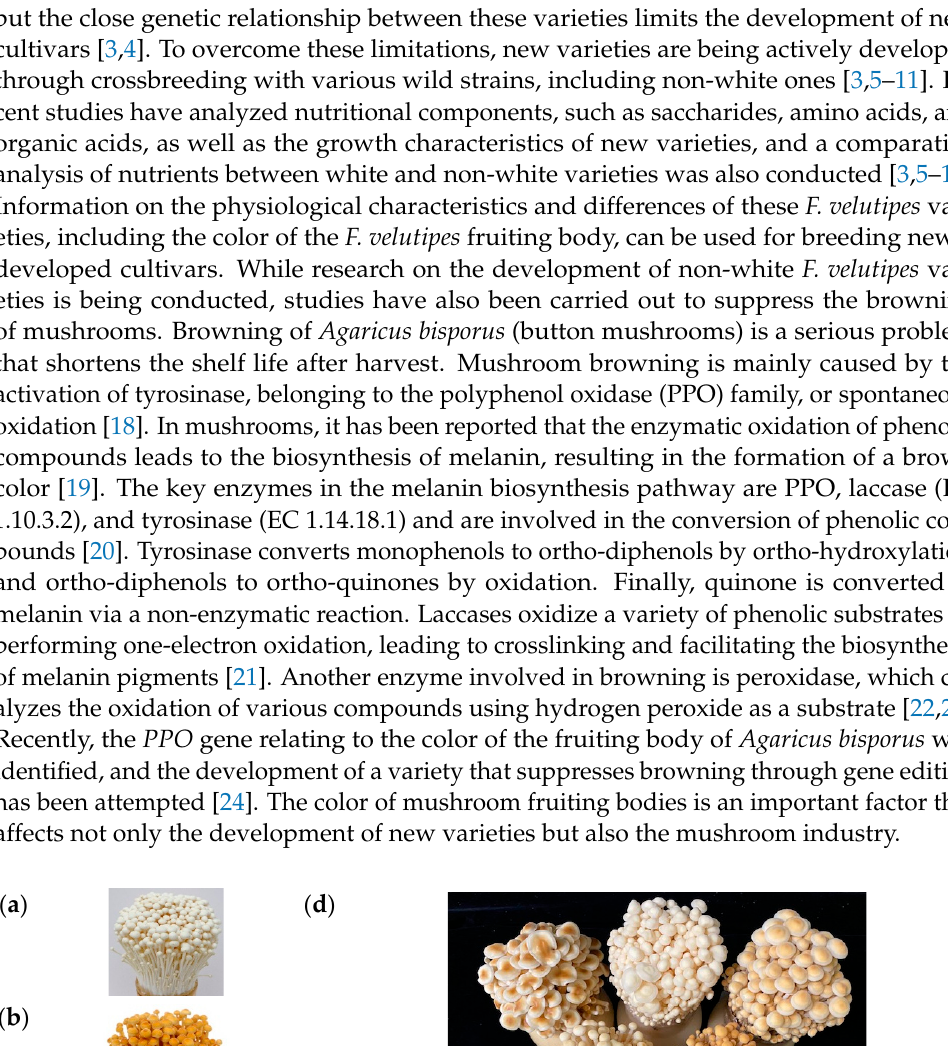
Table 1. Flammulina velutipes strains used in this study.